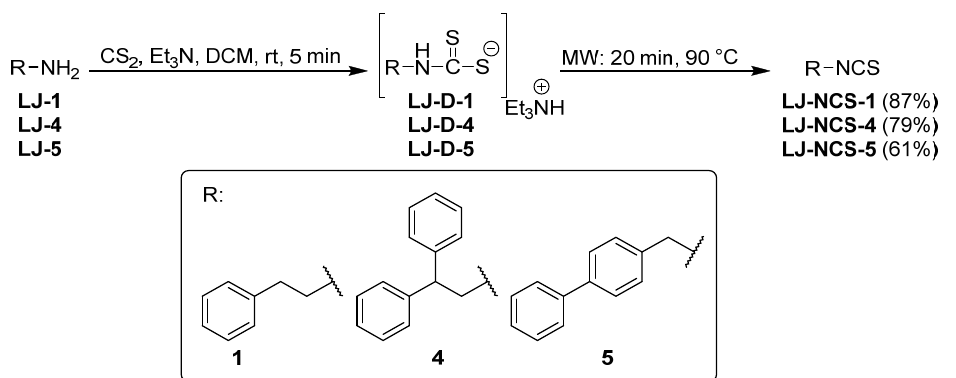
Figure 2. Microwave-assisted synthesis of LJ-NCS-1, LJ-NCS-4, and LJ-NCS-5.